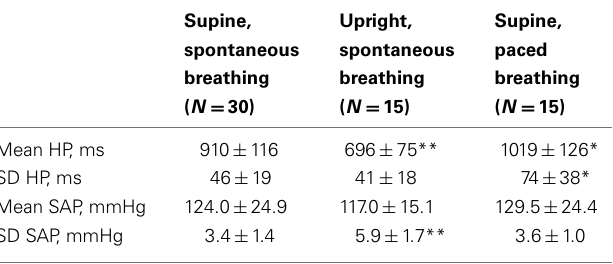
systolic arterial pressure (SAP) variability during tilt test and paced breathing protocols.